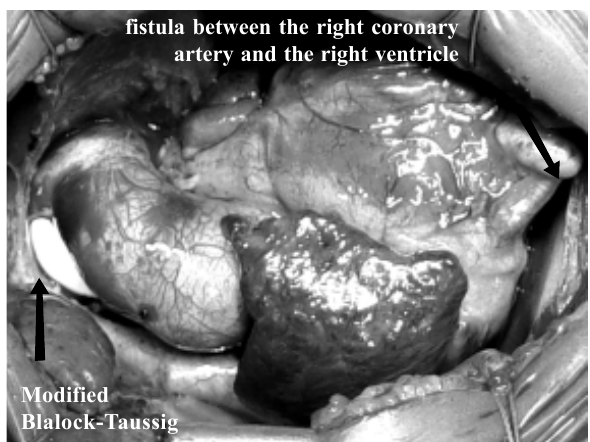
Modified Fig. 1 - Aspect of the heart after the operation demonstrating the position of the modified Blalock-Taussig and the presence of the fistula between the right coronary artery and the right ventricle.